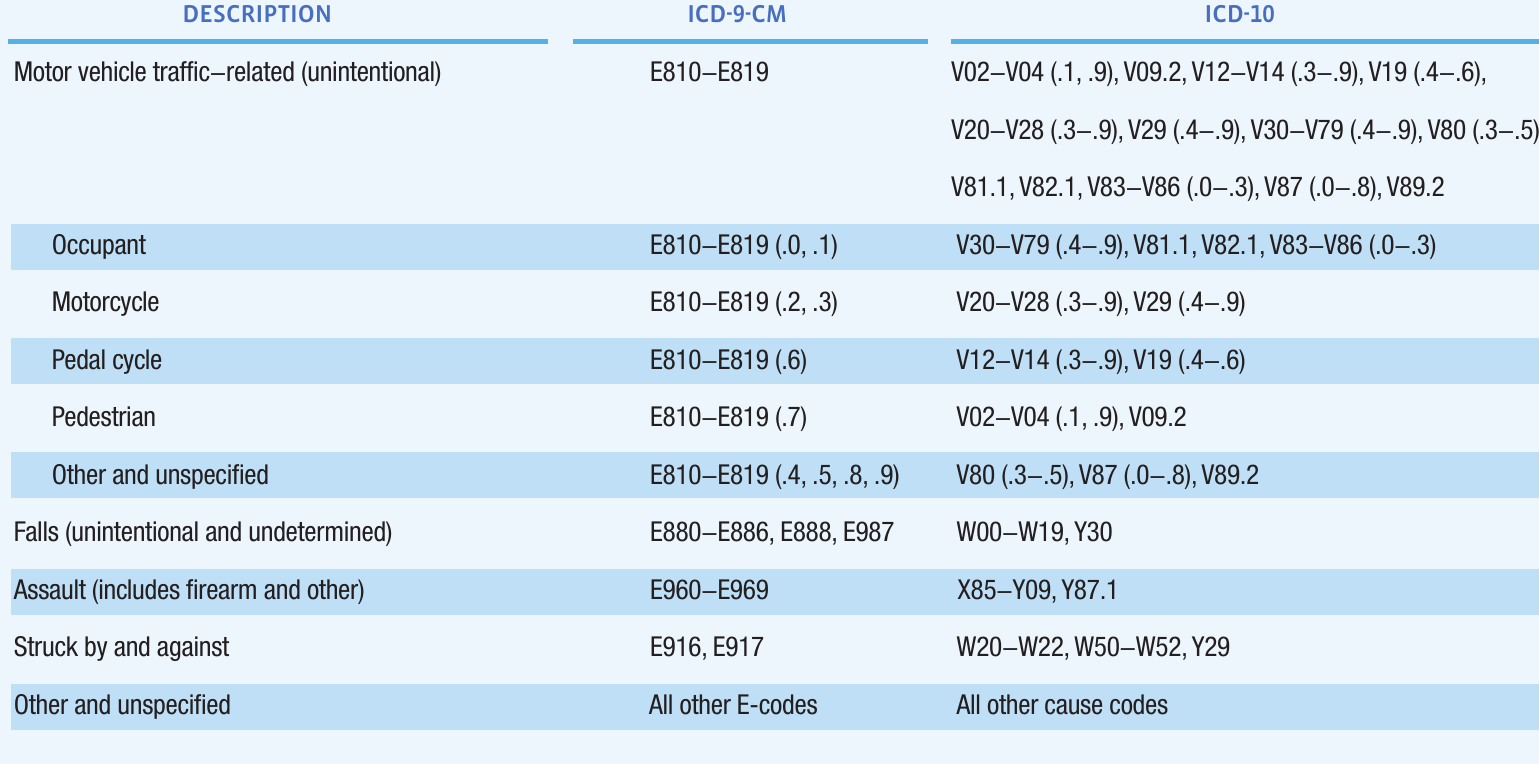
TABLE 20: External Cause of Injury Categorization for ICD-9-CM Codes (Emergency Department Visits and Hospitalizations, 2002–2006) and ICD-10 Codes (Deaths,